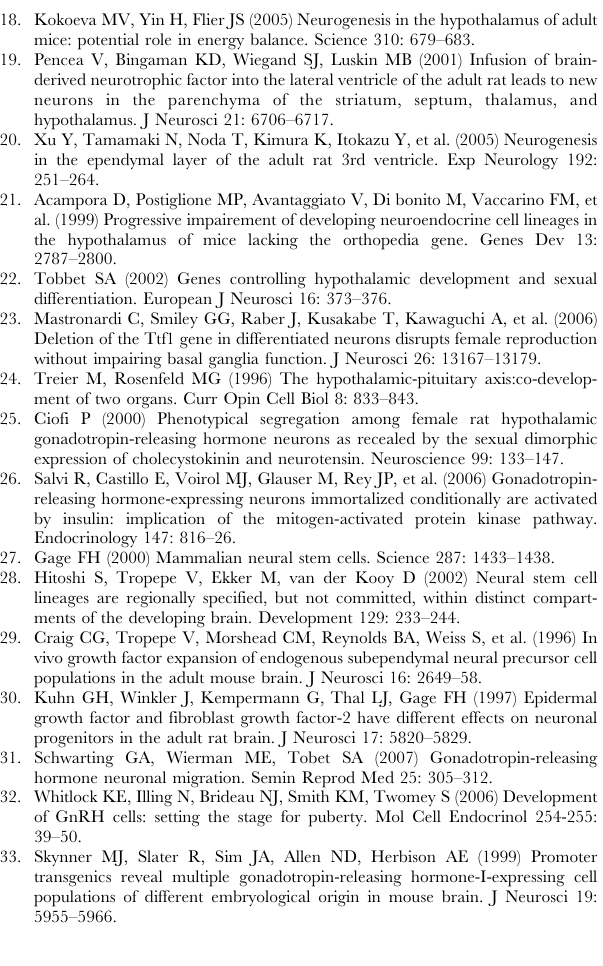
1:100 dilution, Rhodamine-conjugated goat antibody to mouse IgG used at 1:50 dilution, Rhodamine-conjugated goat antibody to mouse IgM used at 1:200 dilution, Rhodamine-conjugated goat antibody to rabbit IgG used at 1:100